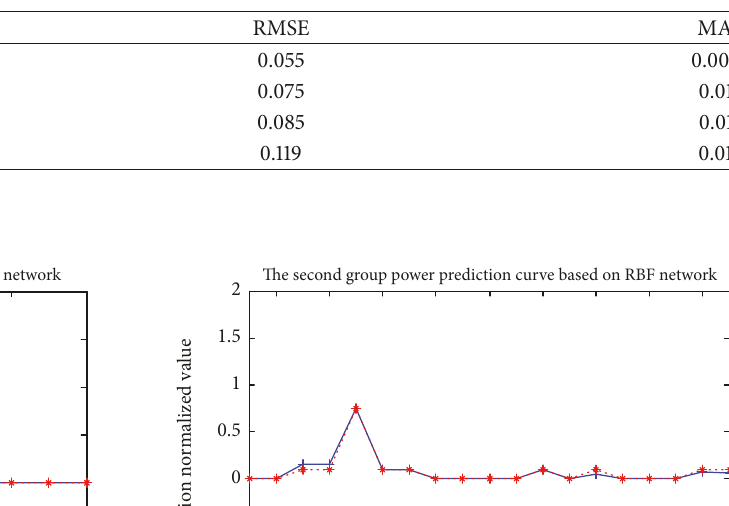
Table 2: Wind power forecast error comparison analysis.